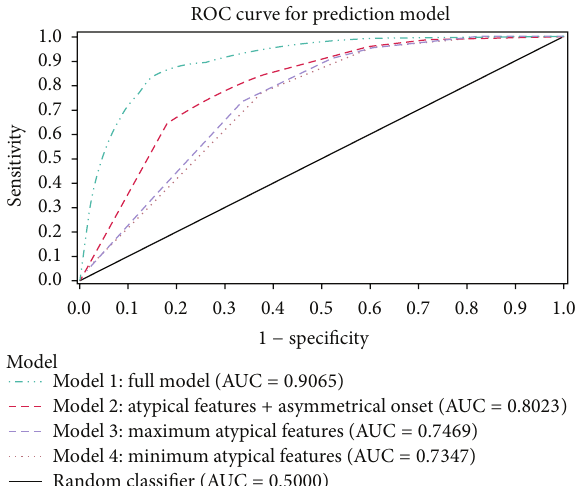
Figure 1: ROC curves for diagnosing iPD based on symptoms and medications (ever listed in medical